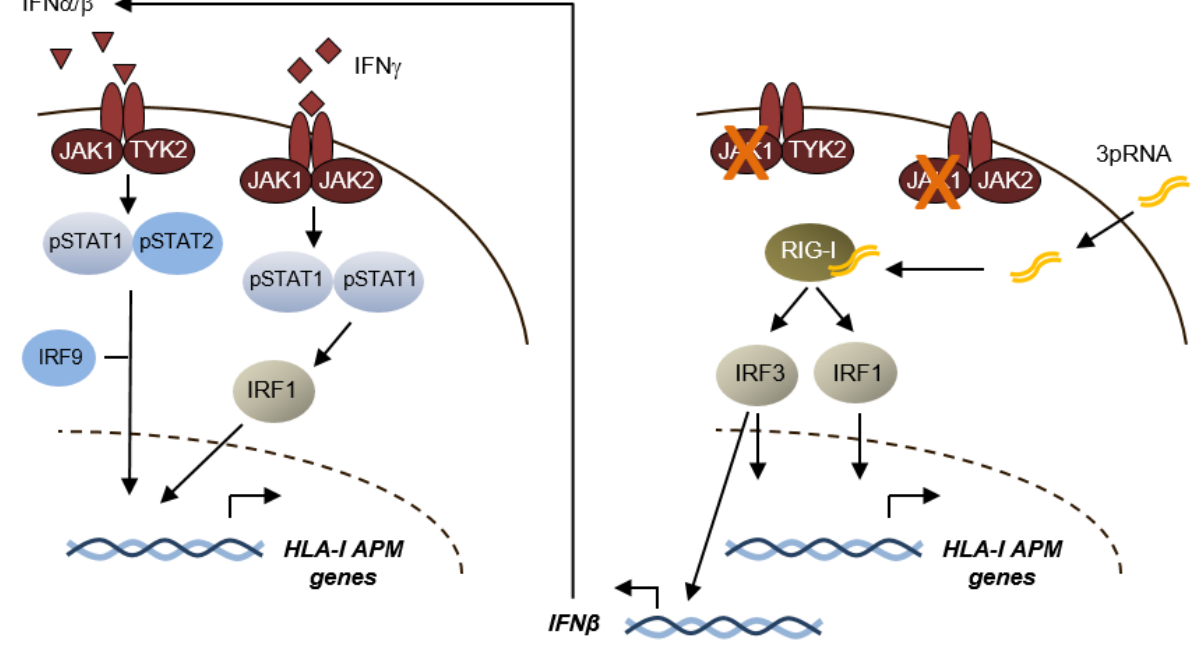
FIGURE 1: IFN-dependent and – independent control of HLA-I antigen processing and presentation genes. Schematic showing signaling pathways and transcriptional regulators involved in the control of HLA-I APM expression. Left, Type I/II interferon signaling; right, RIG-I sig-